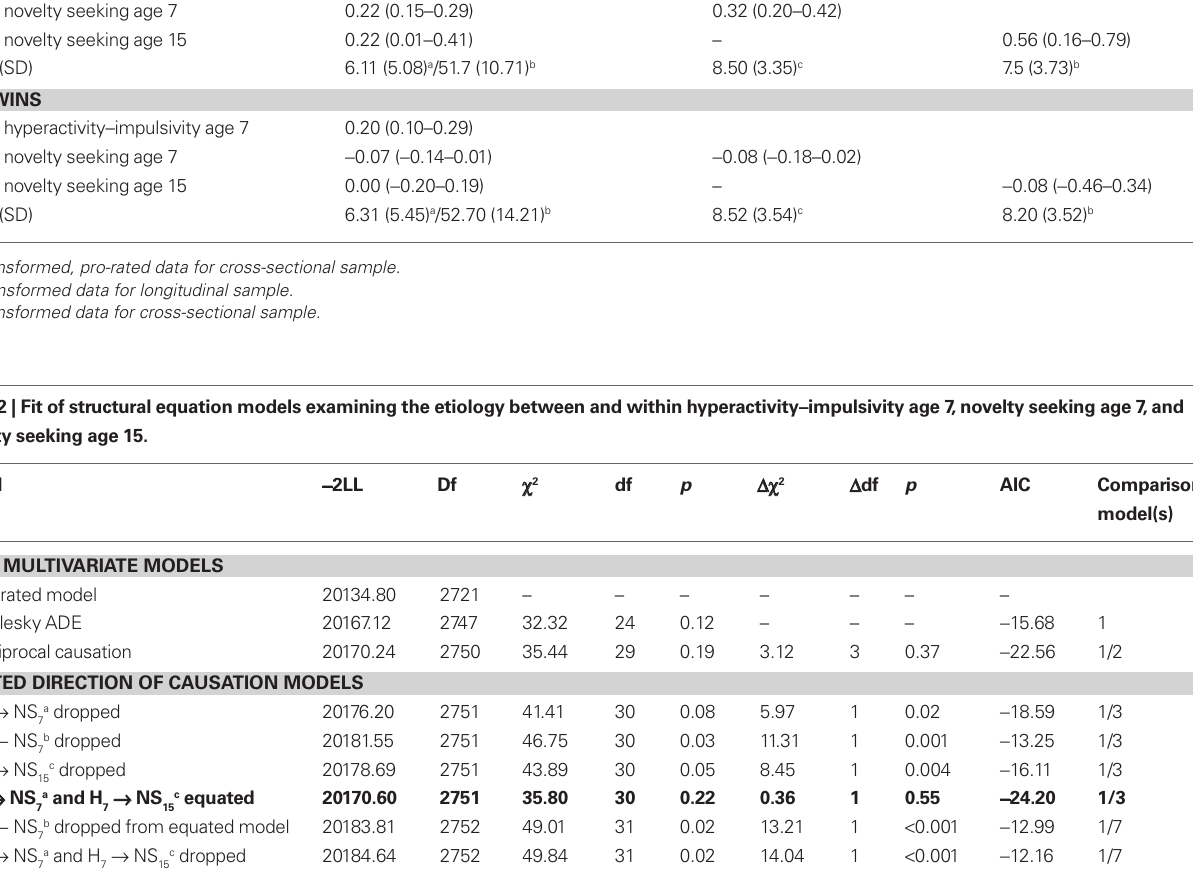
→ NS H represents the cross-sectional causation of hyperactivity–impulsivity at age 7 on novelty seeking at age 7. 7 7 b H ← NS represents the cross-sectional causation of novelty seeking at age 7 on hyperactivity–impulsivity at age 7. 7 7 c H → NS represents the longitudinal causation of hyperactivity–impulsivity at age 7 on novelty seeking at age 7 15